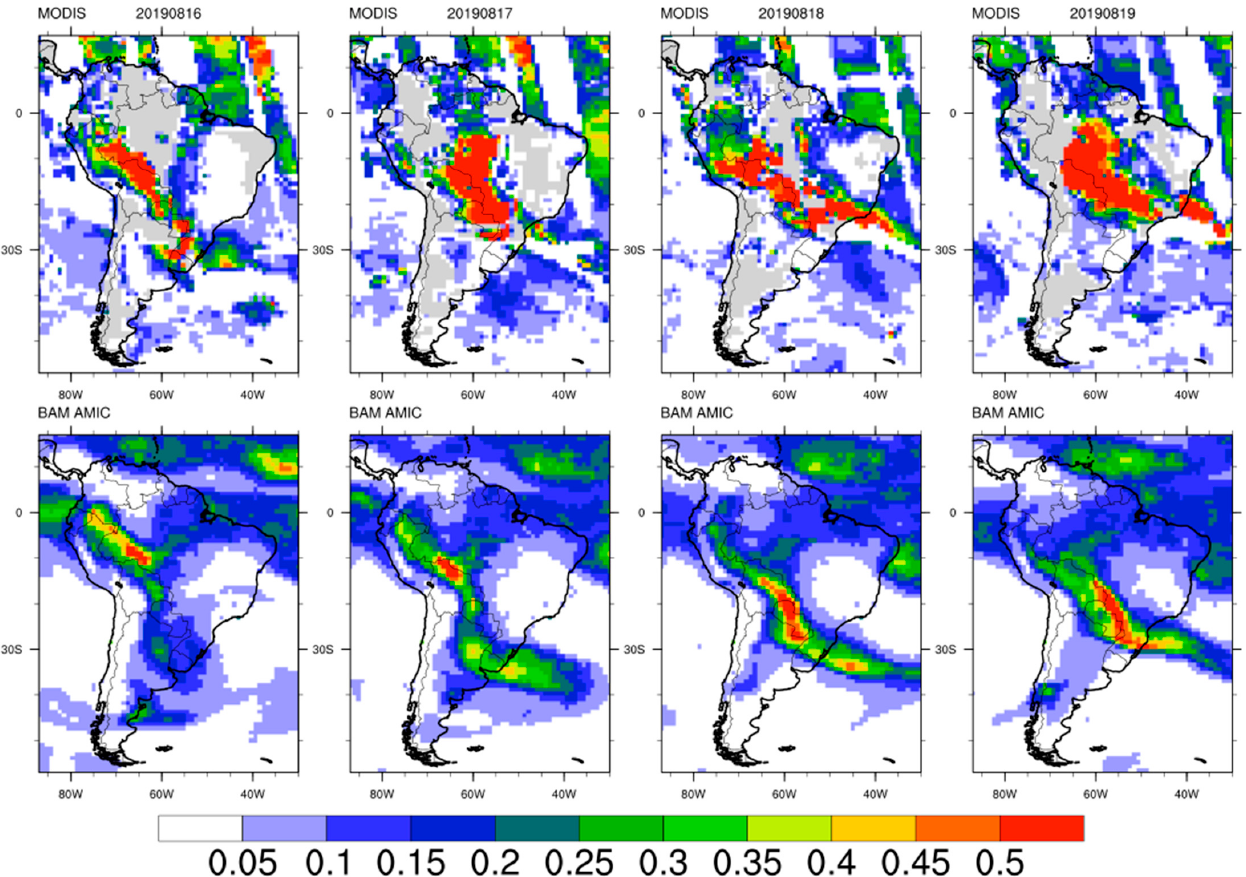
Figure 7. Spatial distribution of AOD during the intense biomass burning event of 16–19 August 2019 over the Amazon from MODIS (top) and BAM AMIC (bottom).